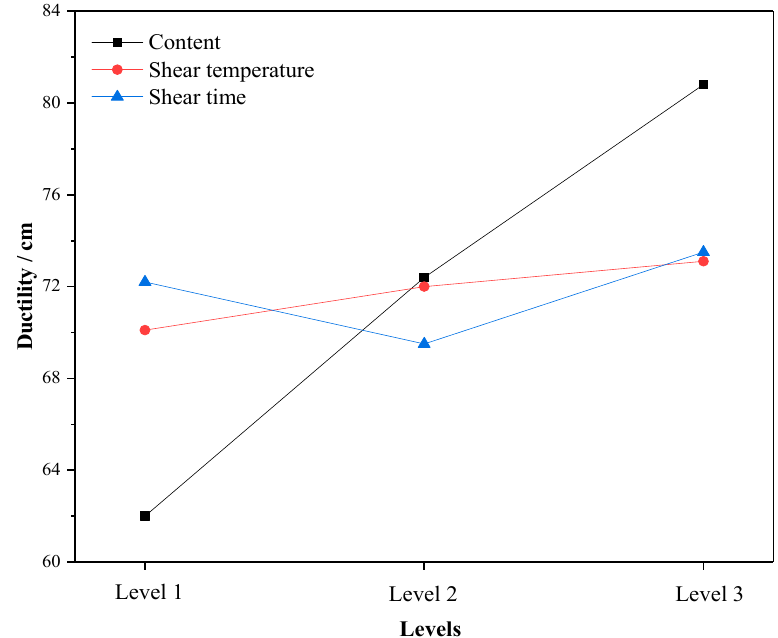
Figure 4. The variation of the mean 5 °C ductility with the levels. Materials 2019 , 12 , x FOR PEER REVIEW